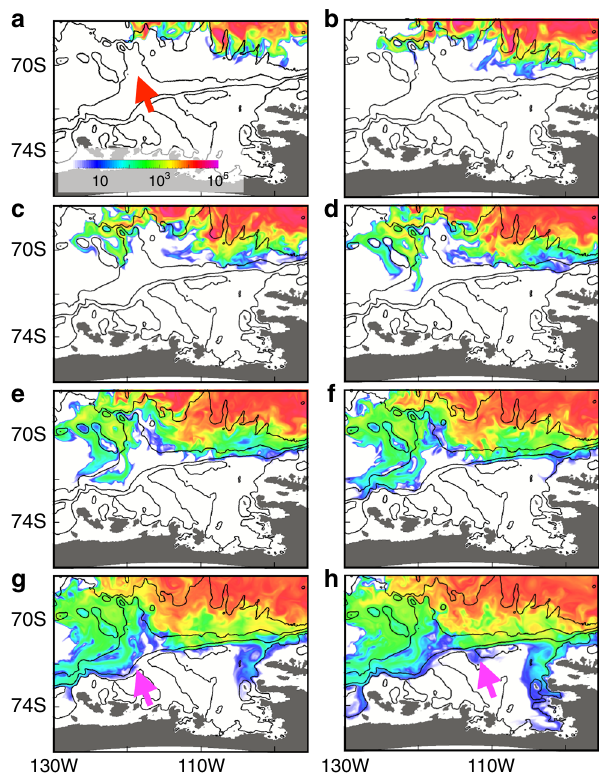
Fig. 5 Monthly mean spatial distributions of vertically integrated TR3. Horizontal distributions of vertical integrated tracer after a 5, b 7, c 9, d 11, e 13, f 15, g 17, and h 19 months of simulation for the CTRL(2009 – 2014) case are shown. Bathymetric contours of 500, 1500, 3000, and 4000 m are shown with thin black contours. The red arrow indicates bathymetric ridge and magenta arrows indicate eastward transport of TR3 by the